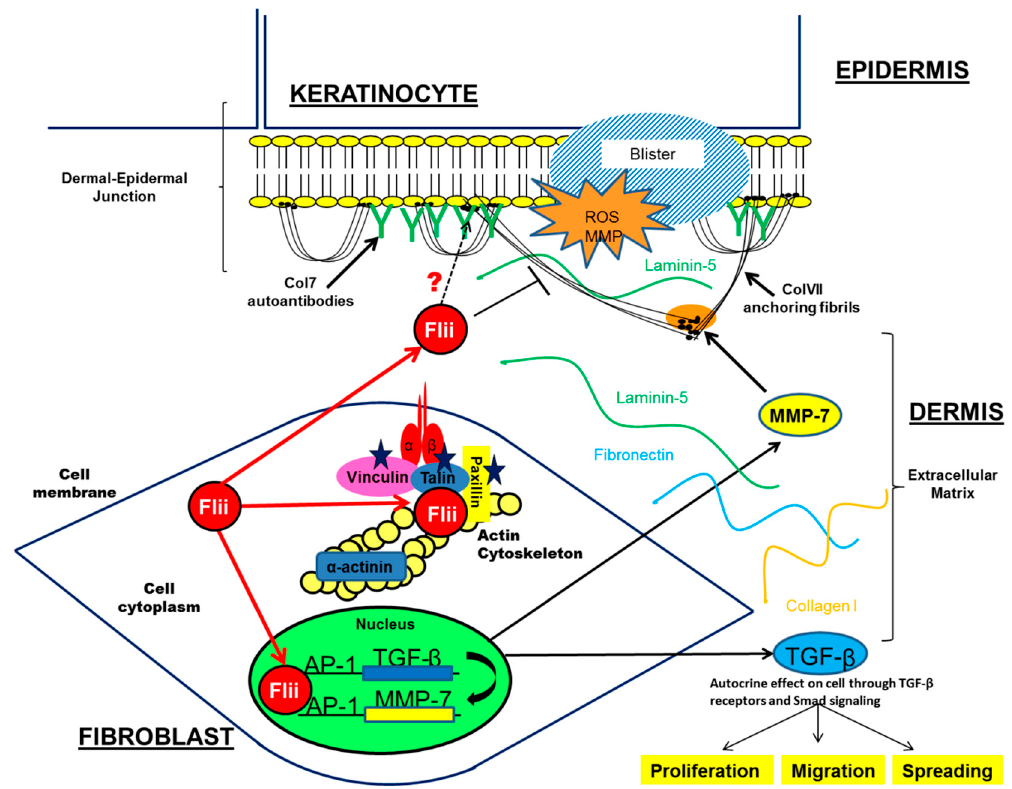
Figure 4. Flii effects on skin blistering in EBA. Intracellularily, Flii associates with intracellular proteins and regulates cell integrin activity and adhesion. In blistered skin, Flii regulates TGF- β